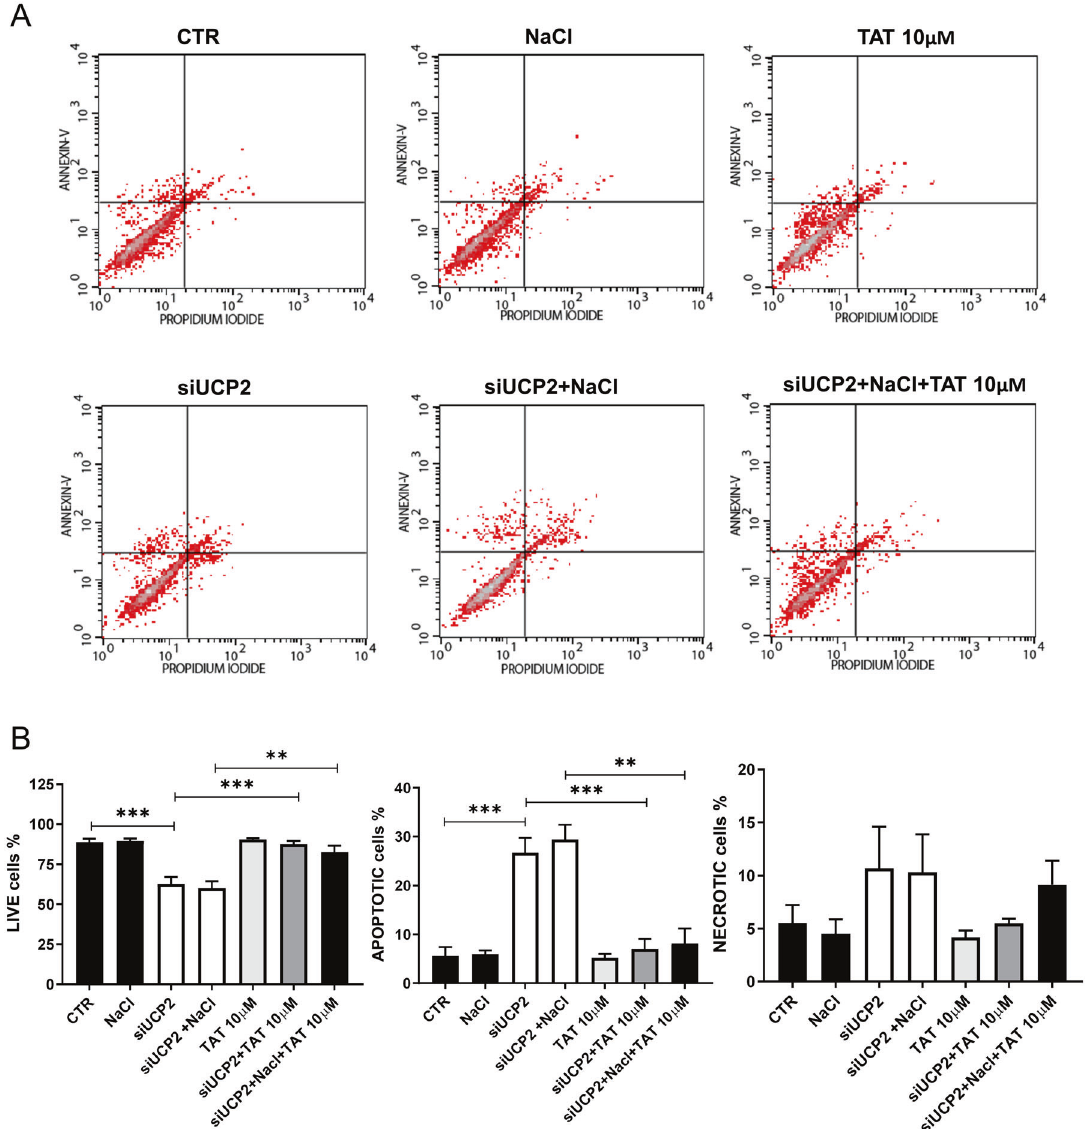
Fig. 7 Reactivation of autophagy rescues cell death in UCP2-silenced proximal tubular epithelial cells. FACS analysis of renal proximal tubular epithelial cells silenced for UCP2 (siUCP2) and treated for 72 h with 20 mM NaCl either in the presence or in the absence of TAT-Beclin D11 (10 μ M) ( N = 6). Representative scatter plots ( A ) and quanti fi cation of live, apoptotic, and necrotic cells ( B ) are reported. CTR indicates not transfected and not treated cells. ** p < 0.01, *** p < 0.001 obtained using the one-way ANOVA followed by Bonferroni post hoc analysis. Data are reported as mean ±